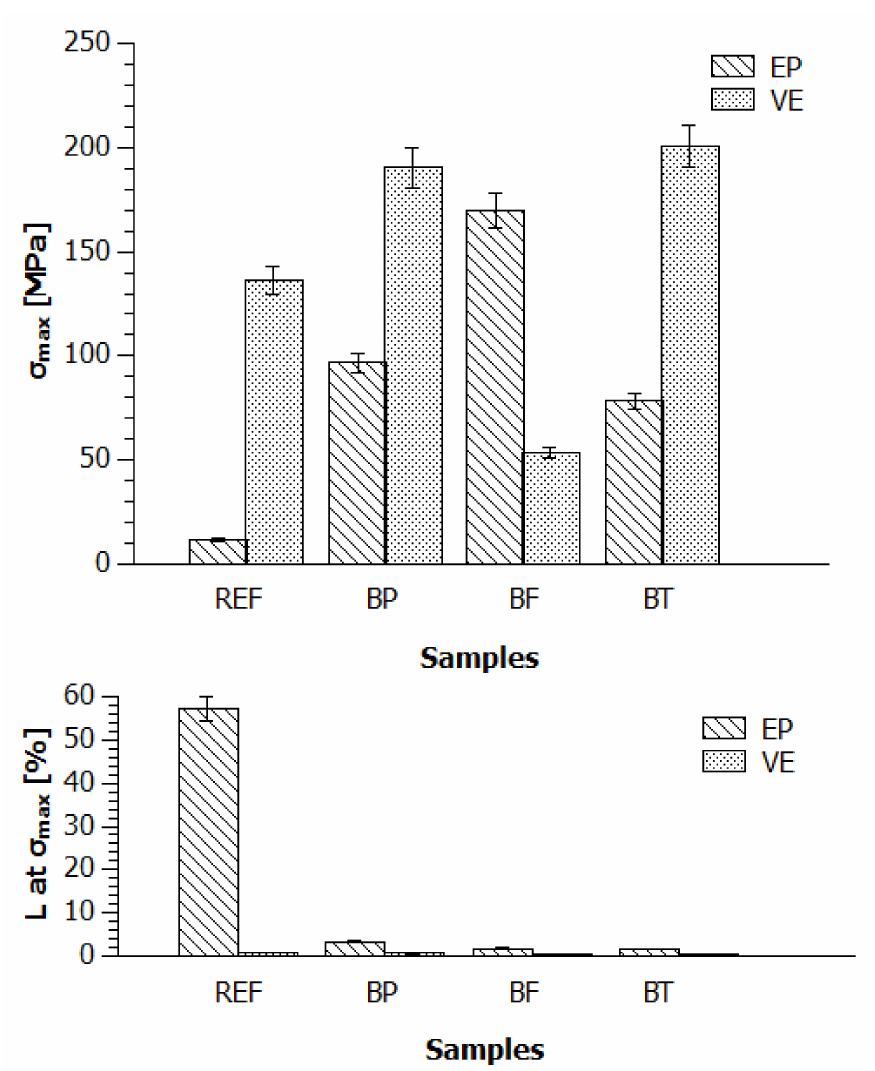
Figure 5. Relation between σ max and corresponding tensile deformation at maximum stress point (L at σ max ) for composites EP and VE reinforced with basalt powder (BP), basalt fibre (BF) and basalt. textile (BT) based on the measurements at 80 ◦